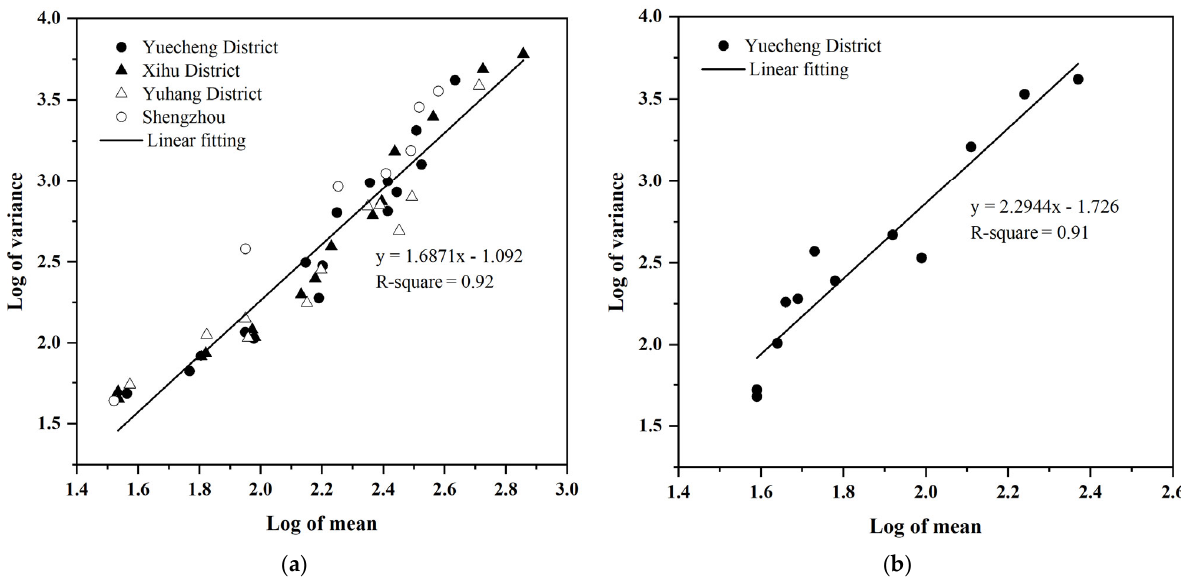
Figure 4. Linear relationship between variances and means of D. minowai on tea leaves in Zhejiang